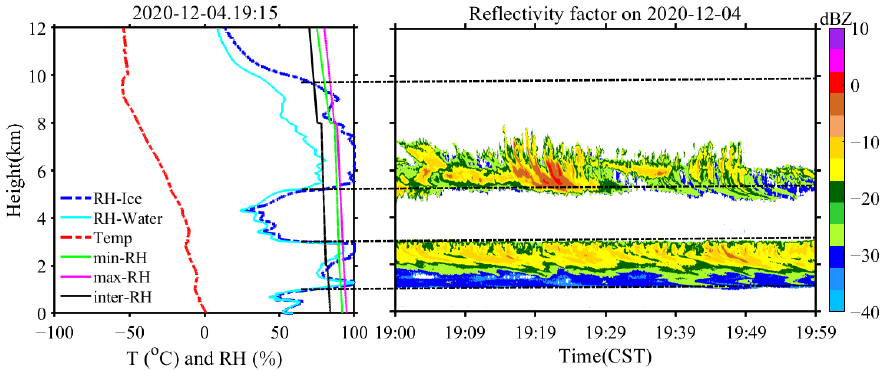
Figure 5. Two-layer cloud detected by the radiosonde and MMCR on 4 December 2021 (radiosonde temperature and RH profile ( left ), reflectivity factor THI from the MMCR ( right ).